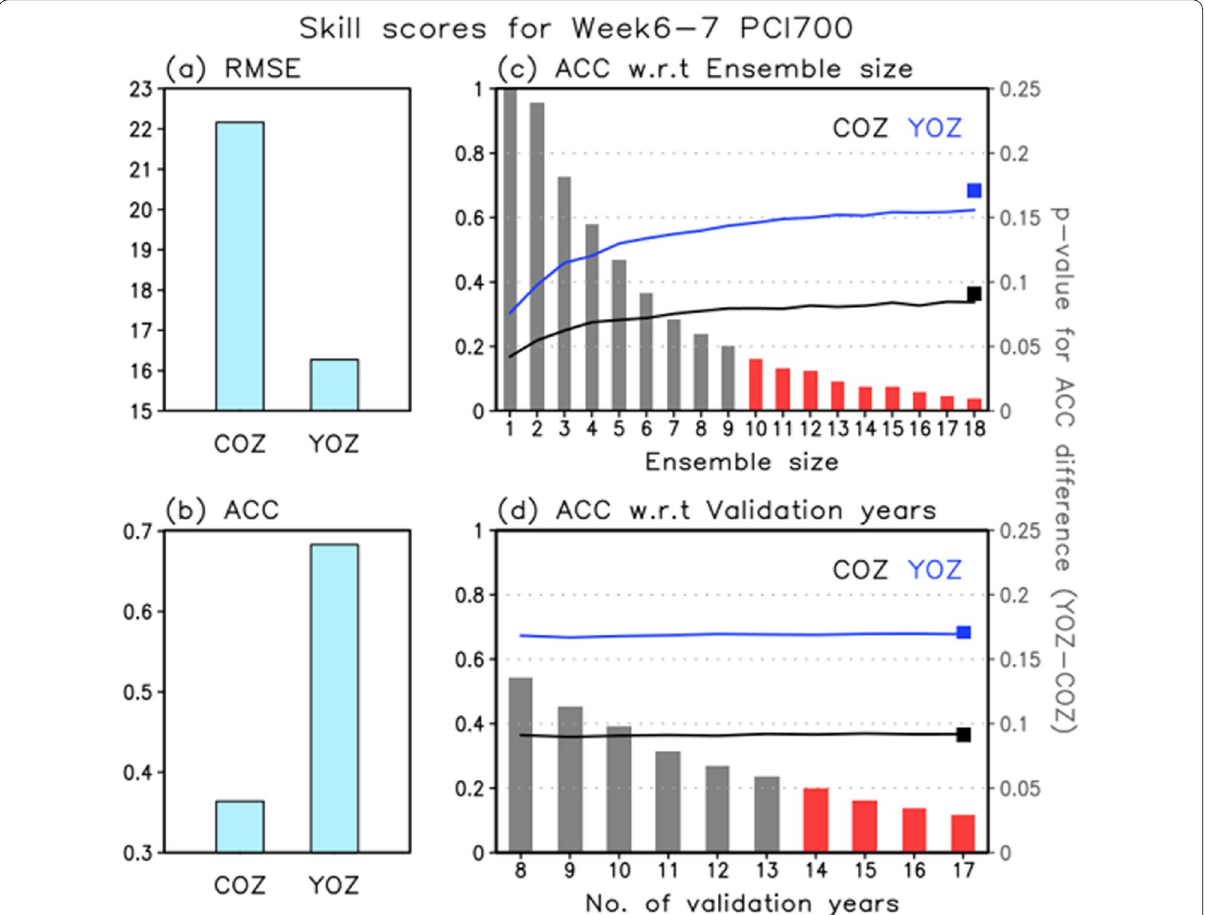
Fig. 3 a Root‑mean‑squared error (RMSE) (m) and b ACC of 700‑hPa PCI at the forecast week 6–7 in COZ and YOZ experiments. c , d ACCs of week 6–7 PCI700 as a function of ensemble size and number of validation years. Each line indicates the average value of bootstrap‑generated 1000 ACCs. Square indicates the practical ACC shown in ( b ). Bars represent p values for the ACC difference (YOZ minus COZ). The ACC difference is statistically significant at the 95% confidence level when the p value is less than 0.05, which is denoted by red